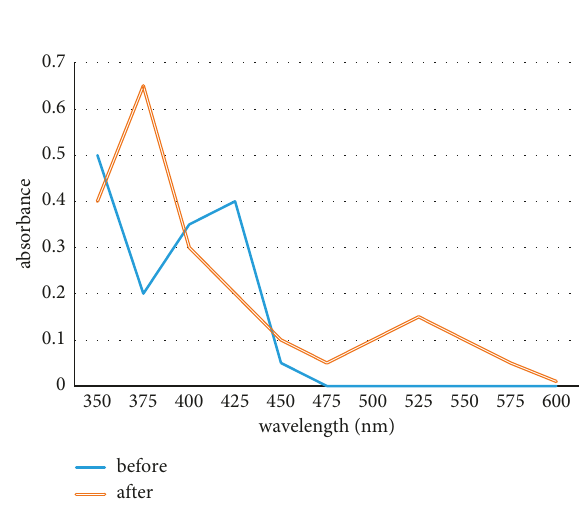
Figure 3: Photochromic change process diagram.